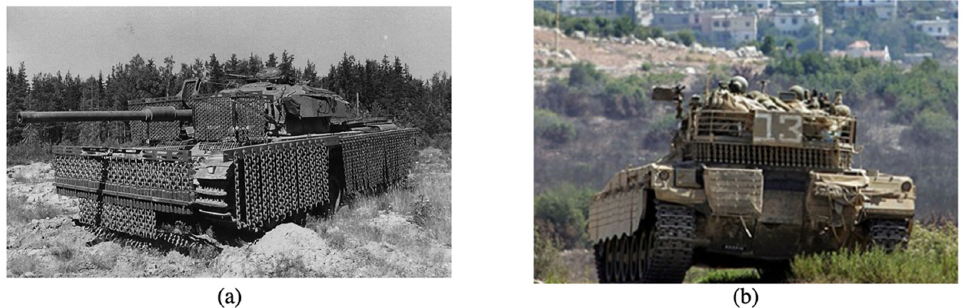
Figure 11. Examples of chain/ball armour applied to a Swedish StrV 102 ( a ) and an Israeli Merkava ( b ).